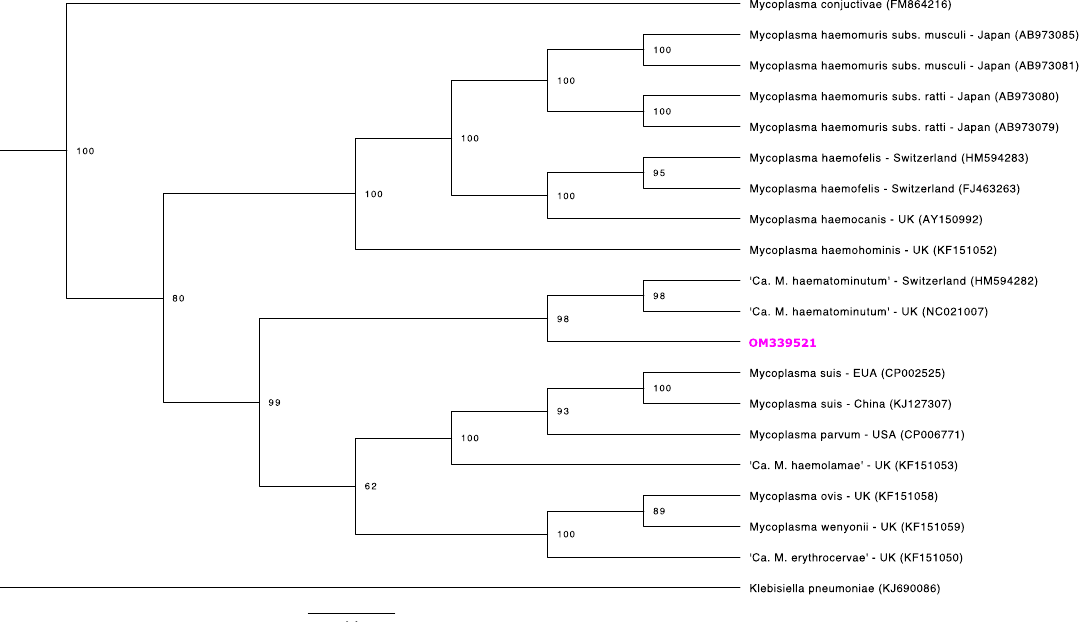
Figure 4. Phylogenetic tree based on partial dnaK gene fragments of Mycoplasma sp. Tree was constructed by Bayesian Inference and a sequence from Klebisiella pneumonia (KJ690086) was used as outgroup. Sequences obtained in the present study is highlighted in pink, once it fits in Ca1 by the 16S rRNA phylogeny.